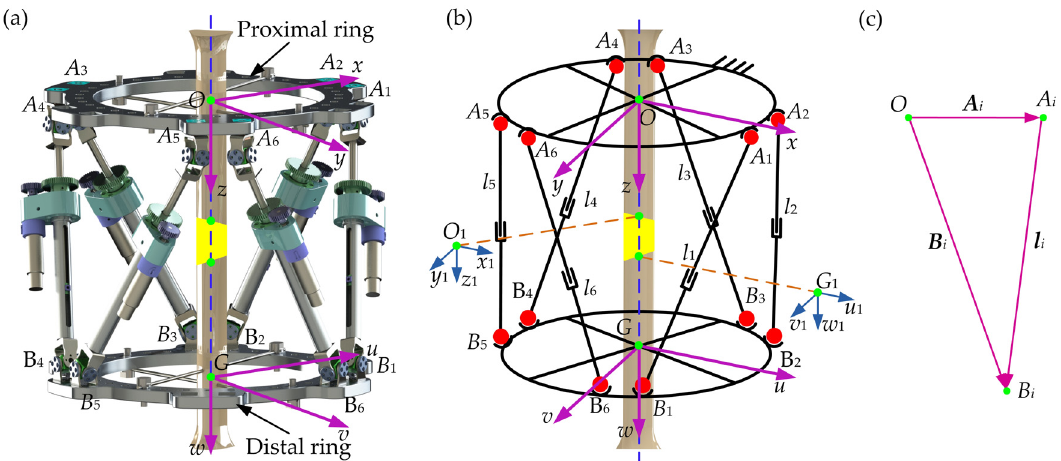
Figure 1. ( a ) The neutral position of the bone-fixator system. ( b ) Schematic diagram of the frame. The points A i ( i = 1,2,...,6) and B i ( i = 1,2,...,6) are the centers of the Hooke and spherical joints. ( c ) The closed vector chain used to solve the vector l i .